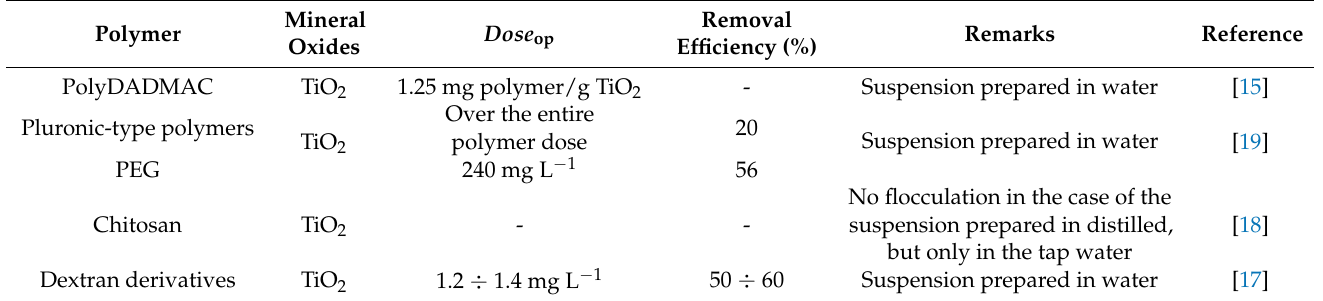
Table 1. Polymer-based flocculants for TiO 2